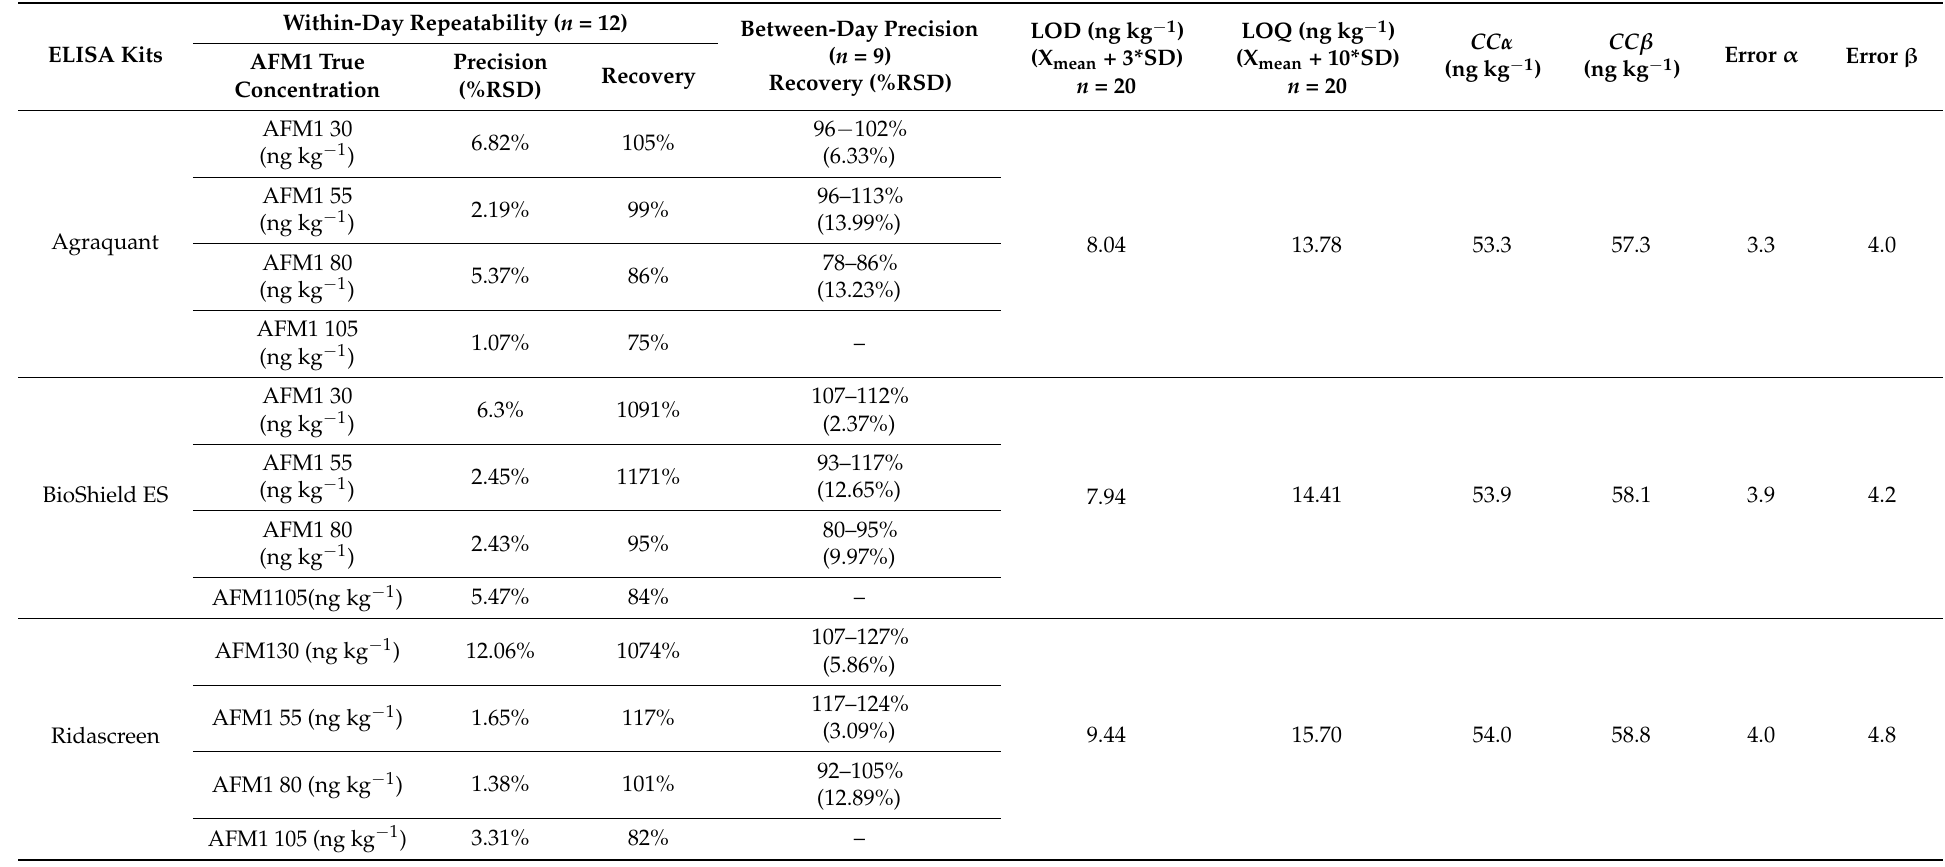
Table 2. Results from the validation of three commercial Enzyme-Linked-Immunosorbent Assay (ELISA) kits of the detection and enumeration of AFM1 in milk samples.